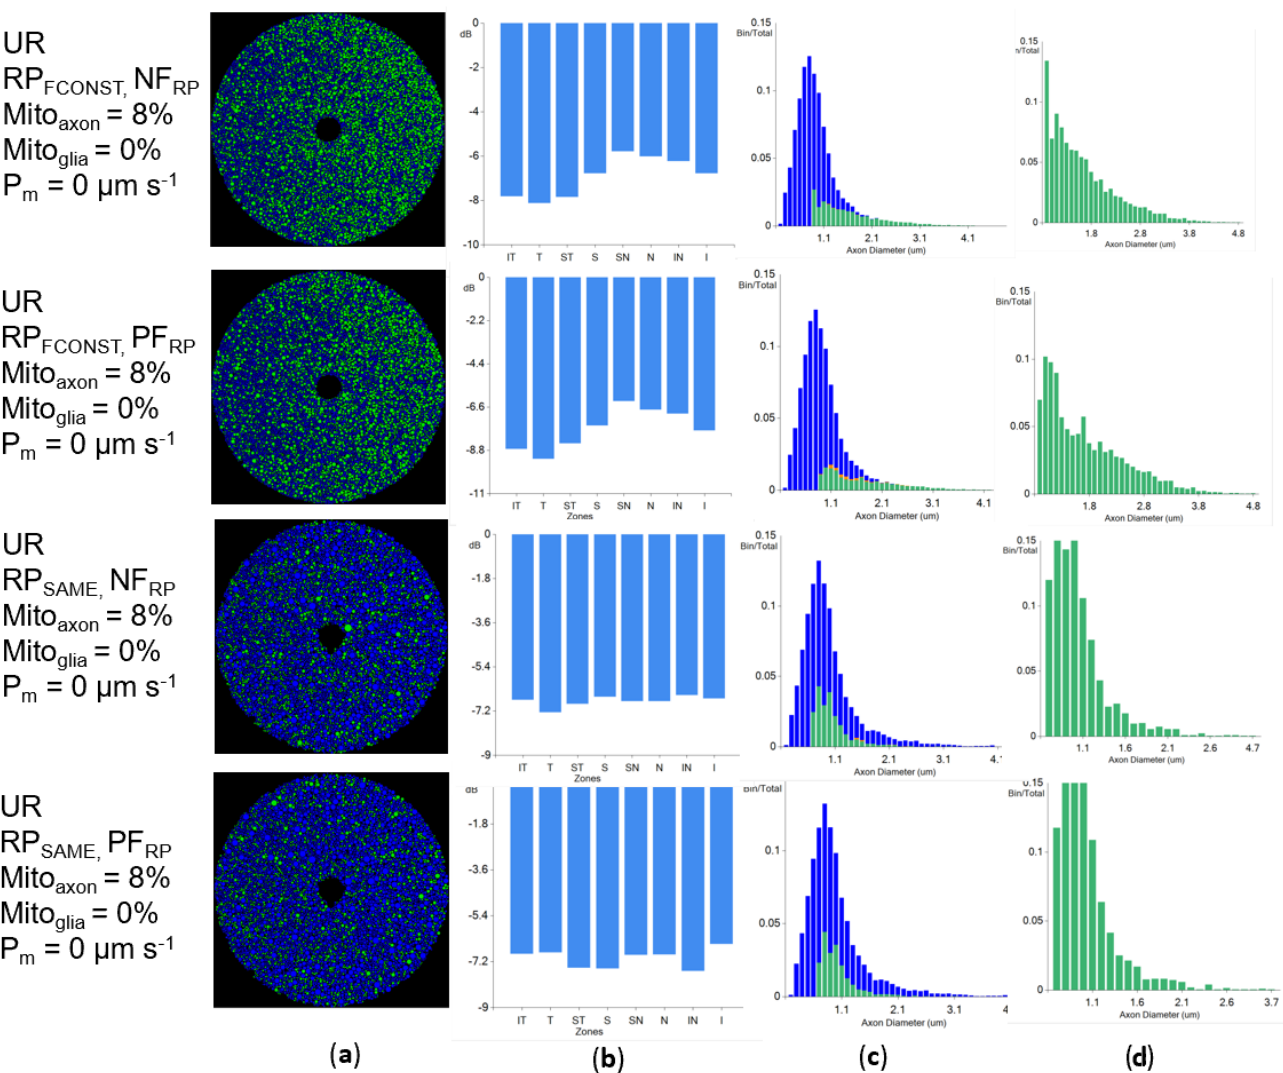
Figure 4. Lack of membrane permeability to ROS species creates evenly distributed zonal loss in the unmyelinated region (UR). NF RP and PF RP simulations have similar end states when the membrane is impermeable: ( a ) Coronal view of axonal state with healthy axons in green and dead axons in blue; ( b ) Coronal octant axonal loss is expressed in dB; ( c ) The distribution of axonal diameters, with green bars representing healthy axons and the blue bars representing the dead axons; ( d ) Diameter distributions for surviving axons.